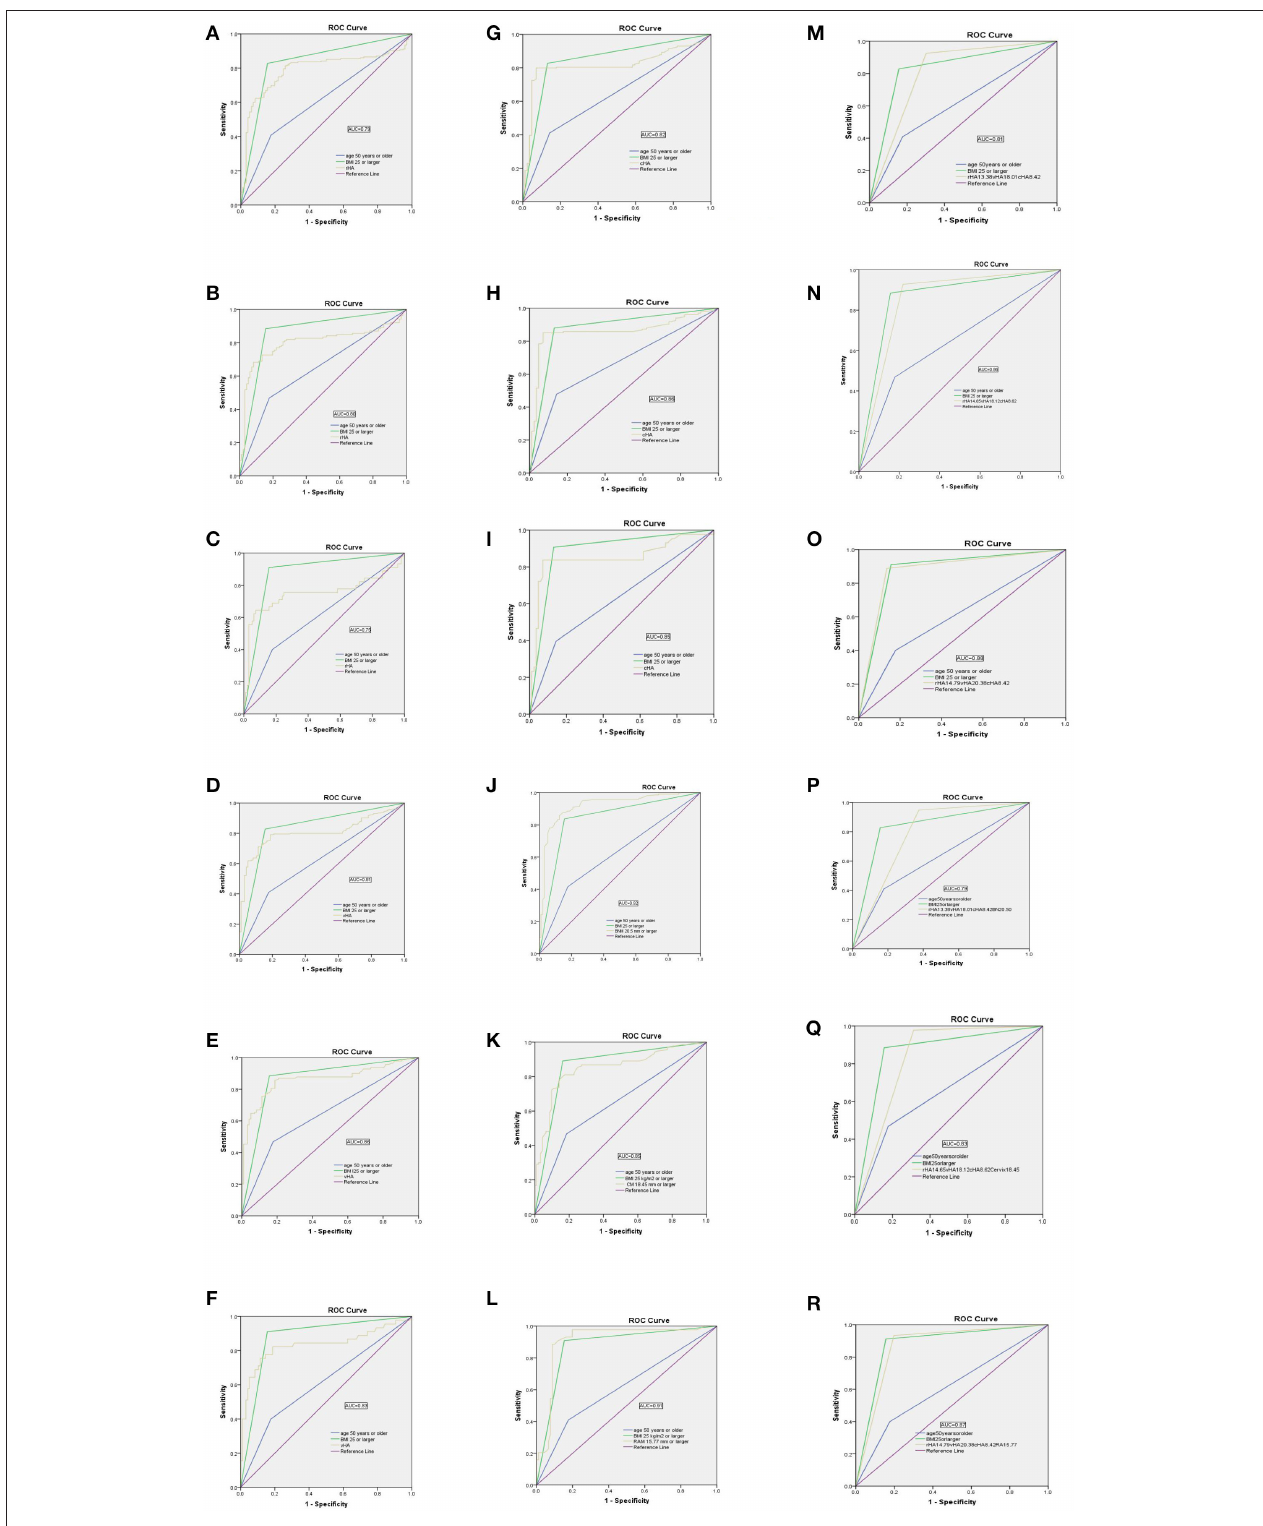
FIGURE 3 | Receiver operator characteristic (ROC) curves showing the performance of the levator hiatus area at rest (rHA), under Valsalva (vHA), at maximal contraction (cHA), bladder neck mobility (BNM), cervix mobility (CM), and rectum ampulla mobility (RAM), separately or in combination, for discriminating between women with and without compartment predominant prolapse (POP-Q, stage 2–3). (A–C) rHA; (D–F) vHA; (G–I) cHA; (J) BNM; (K) CM; (L) RAM; (M–O) rHA + vHA + cHA; (P) rHA + vHA + cHA + BNM; (Q) rHA + vHA + cHA + CM; (R) rHA + vHA + cHA + RAM.